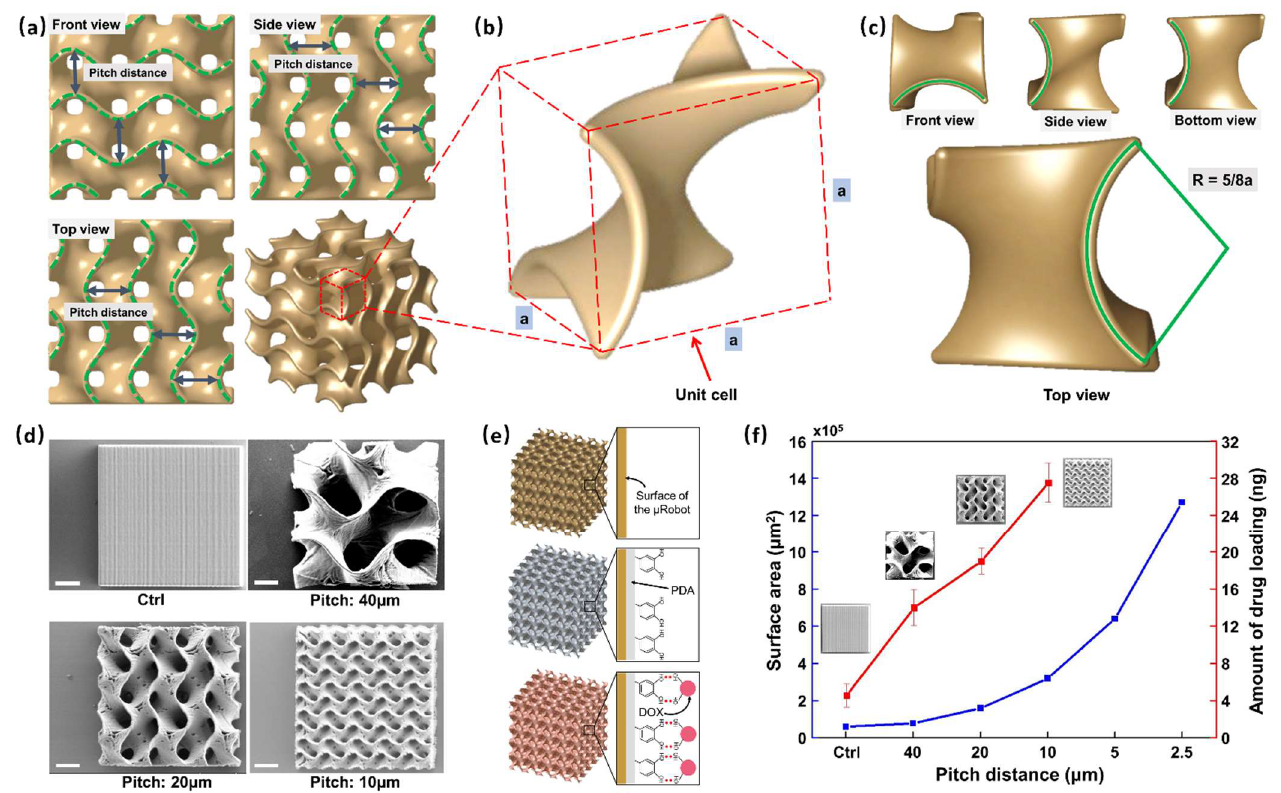
Figure 2. Characterization of the Gyroid surface-microcube (GS-MC). ( a ) Three views of a GS-MC structure; the distance between two green dashed curves is marked as the pitch distance. ( b ) A unit cell of the GS-MC; the designing of unit cell is based on a cubic frame, and the side length is marked as a . ( c ) The top view of the unit cell; the radius of each curve is 5/8 a . ( d ) Scanning electron microscopy (SEM) analysis considering three types of GS-MC (pitch: 40, 20, and 10 μm) and a normal cube. The volume of the cubes is the same at 100 × 100 × 100 μm 3 . (scale bar: 25 μm). ( e ) Schematic of the GS-MC drug-loading mechanism and exerted stimuli-based energy-driven drug release from the GS-MCs. ( f ) Drug-loading capacity (red line) and surface area (blue line) of each cube for different pitch distances.